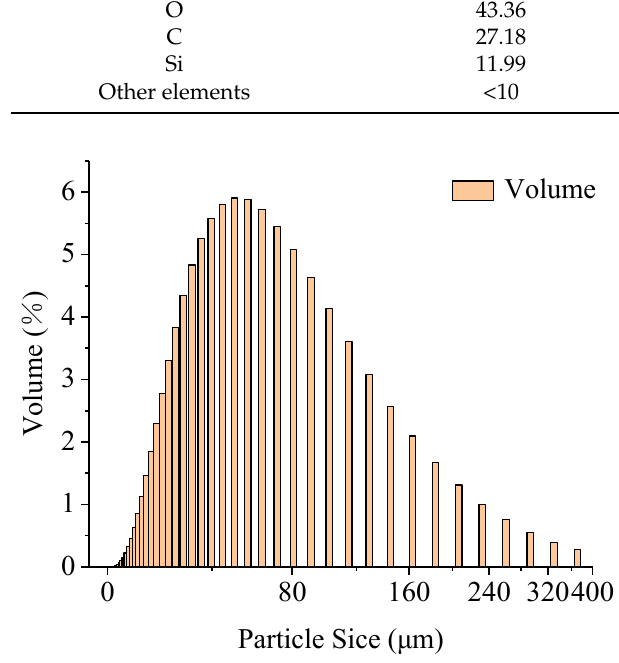
Figure 6. Particle size distribution of fly ash. Table 3. Major chemical constituents of fly ash.